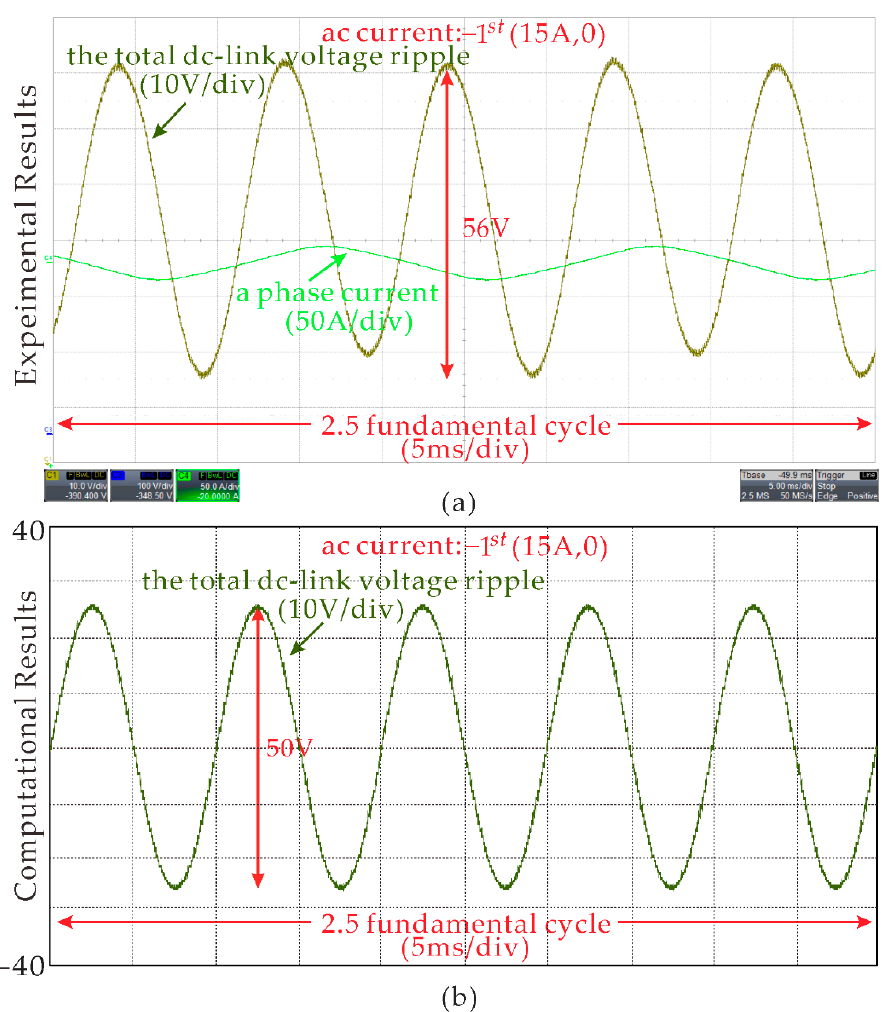
Figure 9. Experimental and computational results of the dc-link voltage ripple when the ac currents contain − 1st (10A, 0): ( a ) experimental results; ( b ) computational results.